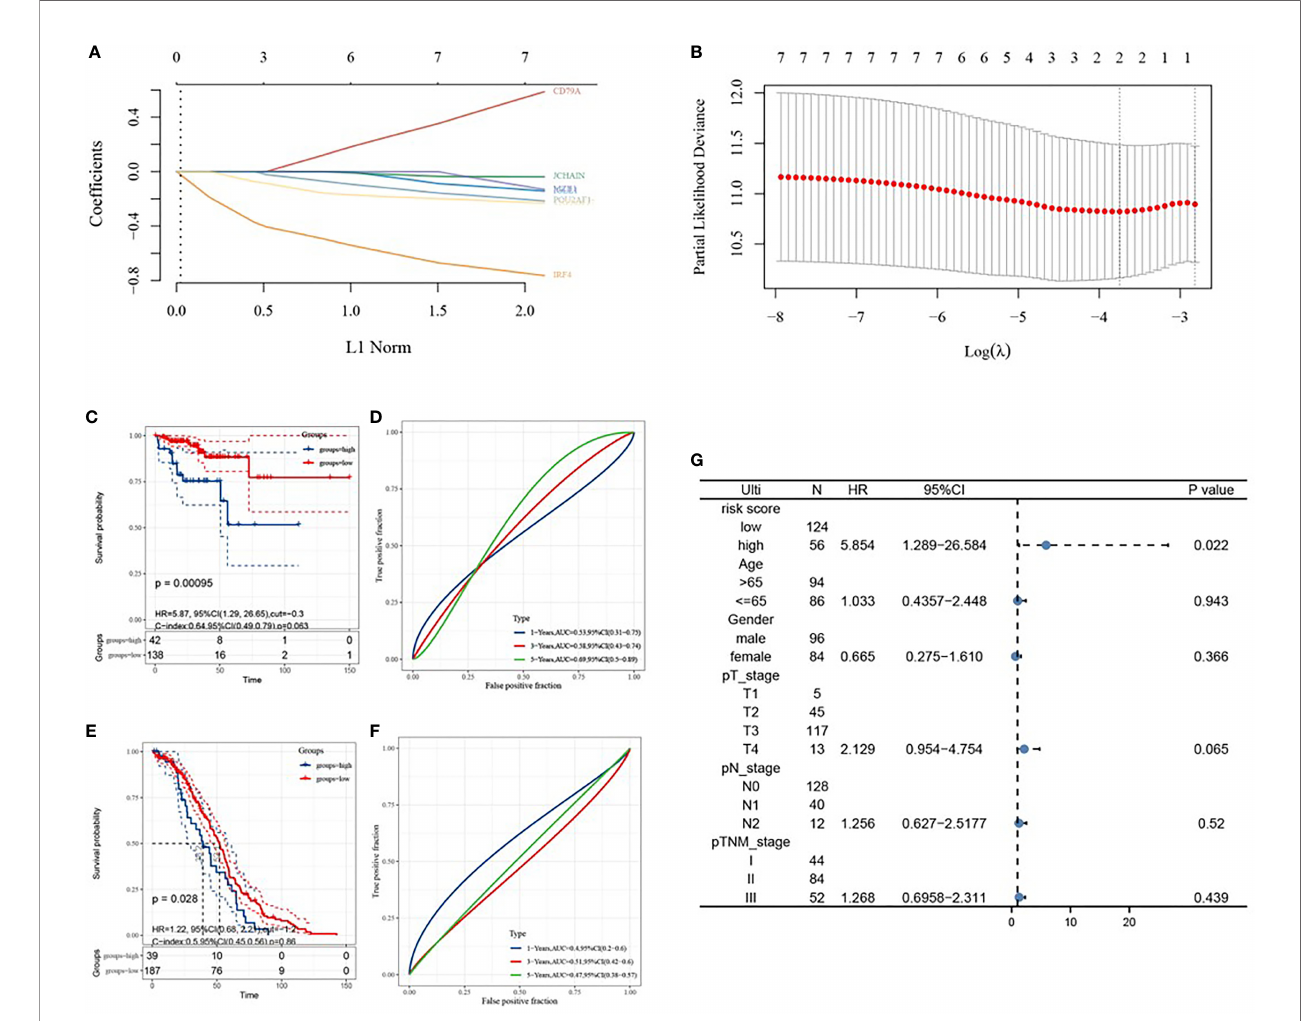
FIGURE 7 | Construction of prognostic features of immune-related genes in colon cancer. (A, B) distribution of LASSO coef fi cients for 7 hub genes to obtain the adjustment parameter l .min=0.0075, and the vertical black dashed line in B de fi nes the optimal l value; (C) Distribution of risk scores of colon cancer patients; (D) KM curve of high and low risk group; (E) ROC curve; (F) Univariate risk proportional regression model; (G) KM curve of high and low risk group, from GSE14333; (H) 1-year, 3-year, and 5-year ROC curves, from